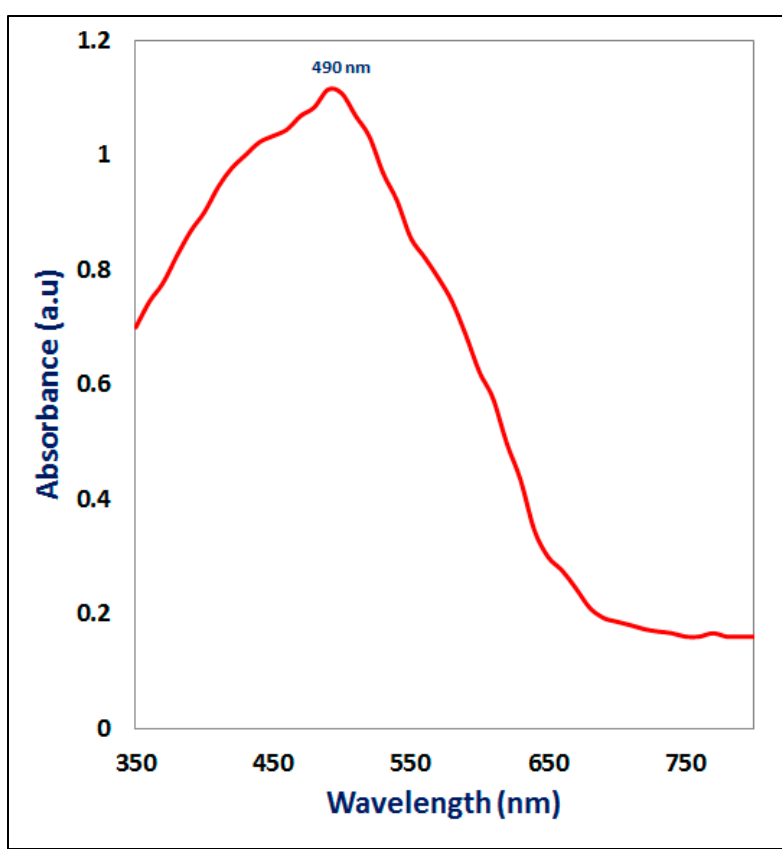
Figure 3. UV–vis spectra of Hem-NPs.